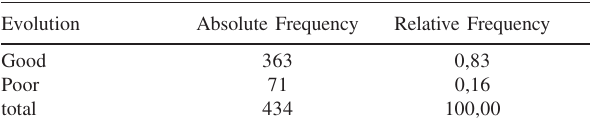
Table 5 - Frequencies observed in treatment results